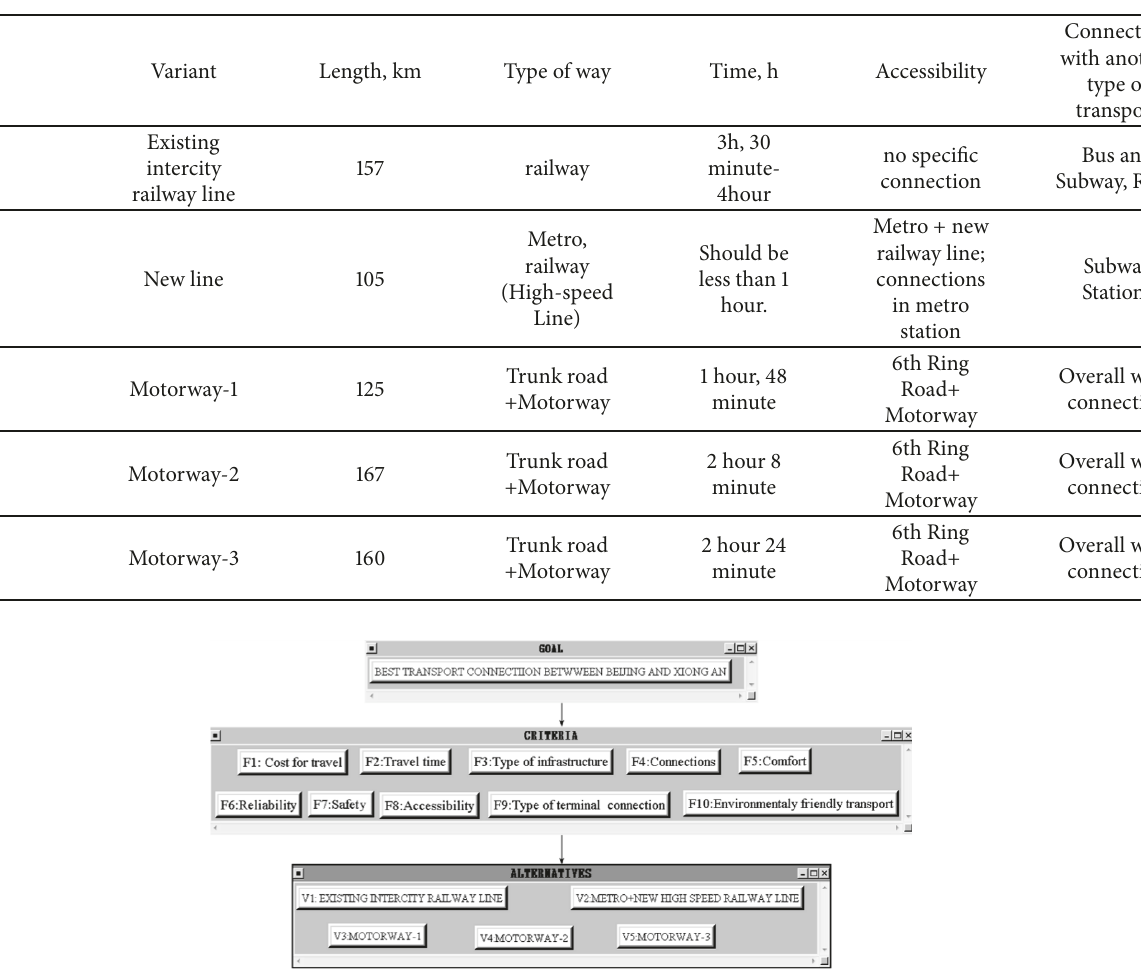
Figure 7: AHP hierarchical model for goals, criteria, and alternatives for the study area.